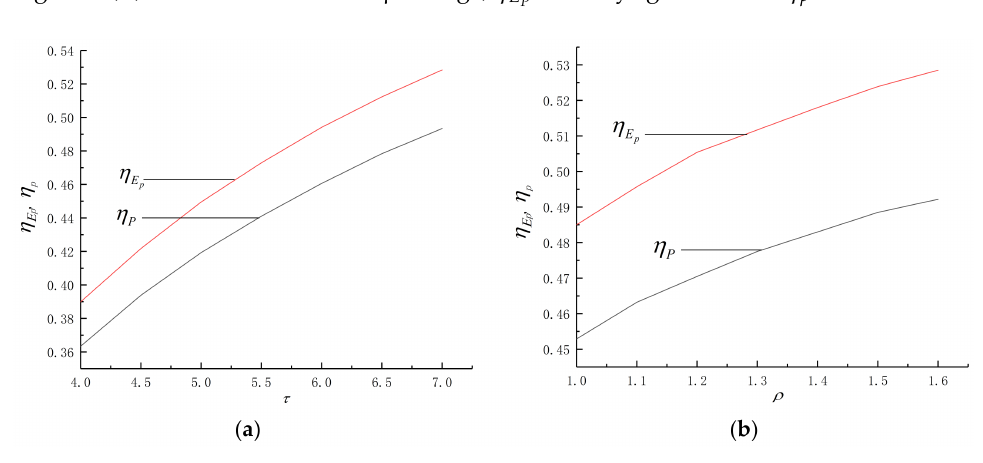
and η p . ( a ) Effect of τ . ( b ) Effect of ρ . P